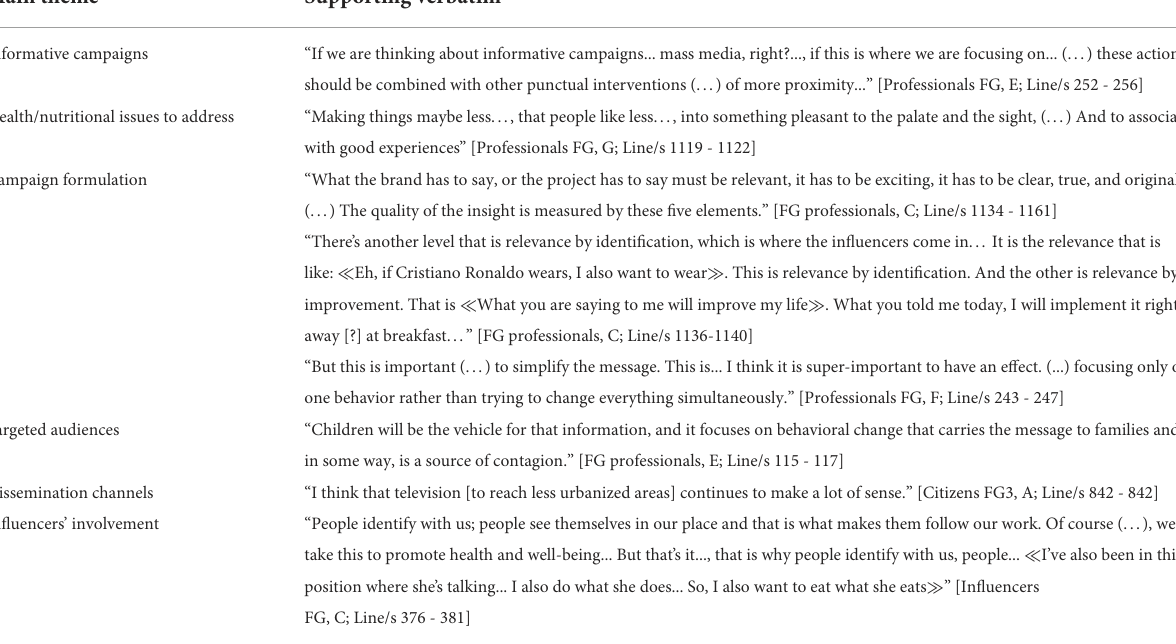
TABLE 3 Supporting verbatim exemplifying the six main themes emerging from the narratives of the focus groups conducted with citizens, health and communication professionals, and digital influencers to explore opinions and attitudes regarding the development of healthy eating promotion mass media